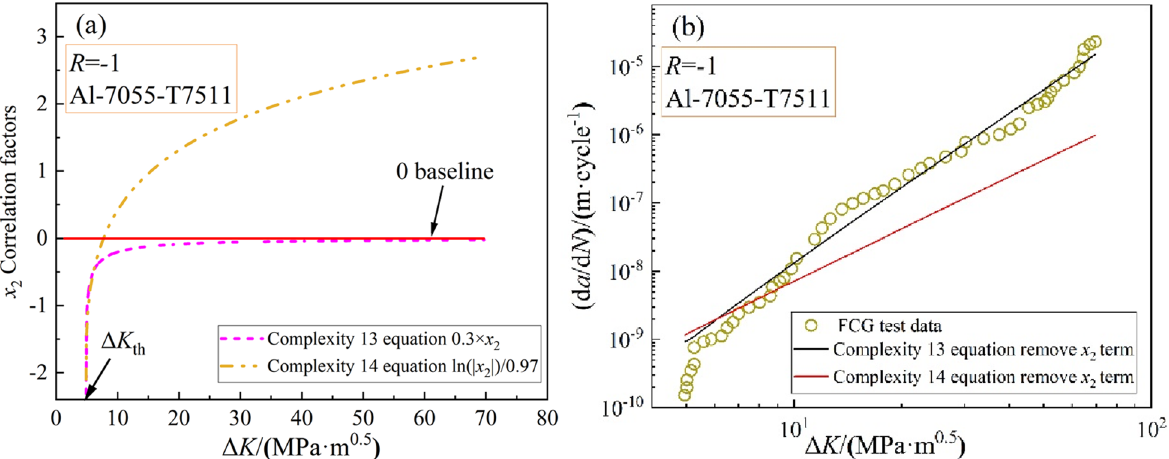
1) FCG process in two SR-undetermined models, a the x 2 term correction = −